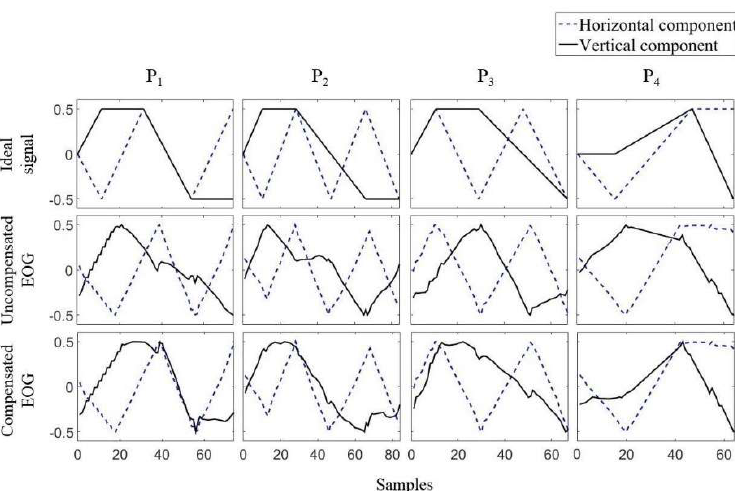
Figure 6. Crosstalk in EOG signals [35]. The horizontal component represents the EOG recorded at the left and right side of the eyes, whereas the vertical component represents the EOG recorded above and below an eye. The ideal signal is the expected EOG when a participant moves his / her eyes as instructed. The compensated EOG is the signal after the crosstalk is removed from the obtained (uncompensated) signal.